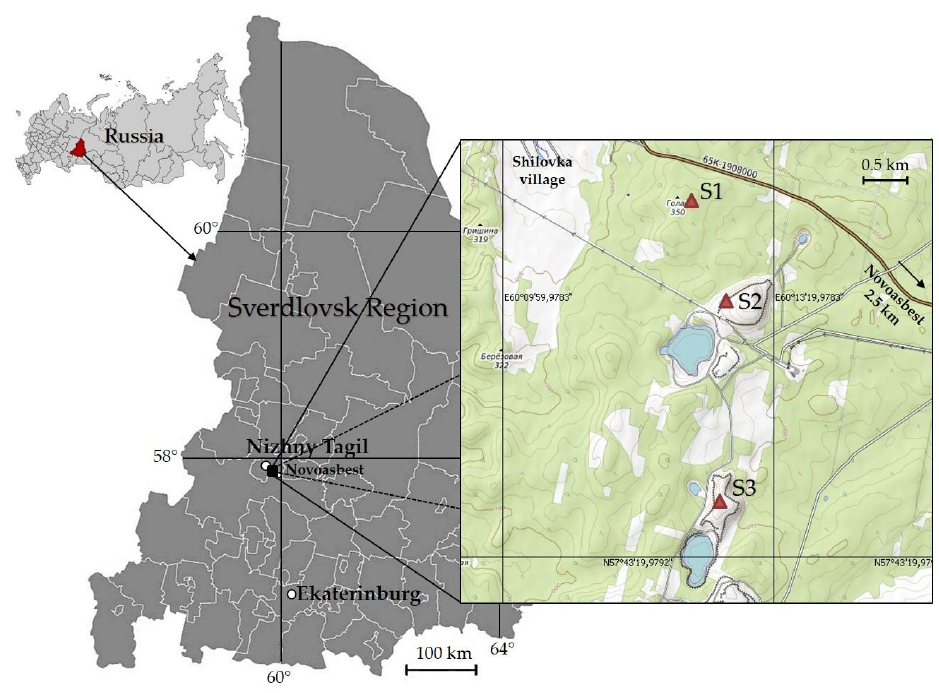
Figure 2. The studied sites of E. atrorubens populations (S1 – S3) in the Sverdlovsk region, Russia. The study area climate is characterized by a continental subarctic climate with an average annual air temperature of +1.0 ◦ C; the average July temperature is +17.2 ◦ C and the average January temperature is − 16.0 ◦ C (according to the weather station in Nizhny Tagil) [32]. The average annual rainfall is 628 mm. The snow cover lasts from the